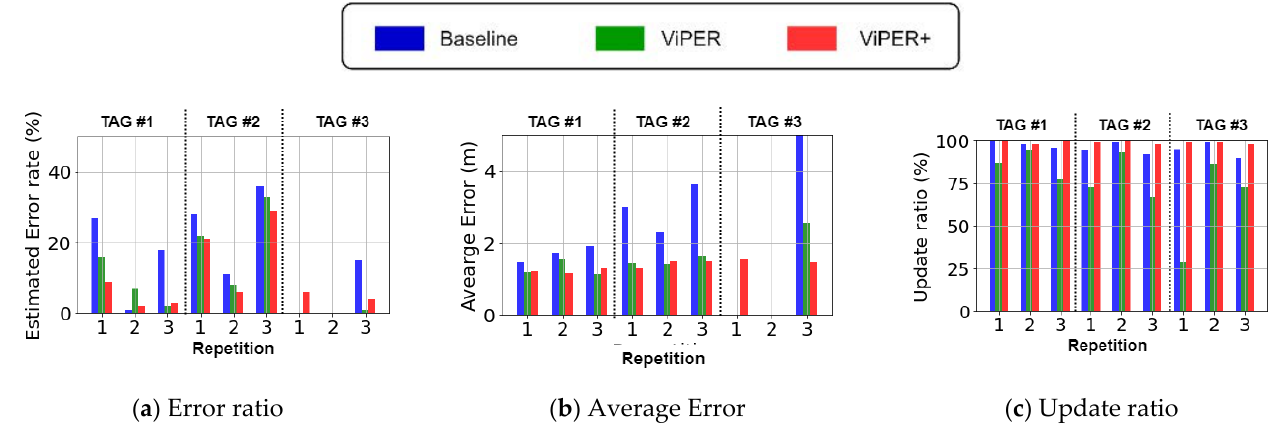
Figure 13. Worker tracking results for scenarios with blocking objects. With ViPER+ for localization of the tags, we achieved the same update rate as the baseline method, while having a low error ratio and average error as ViPER.